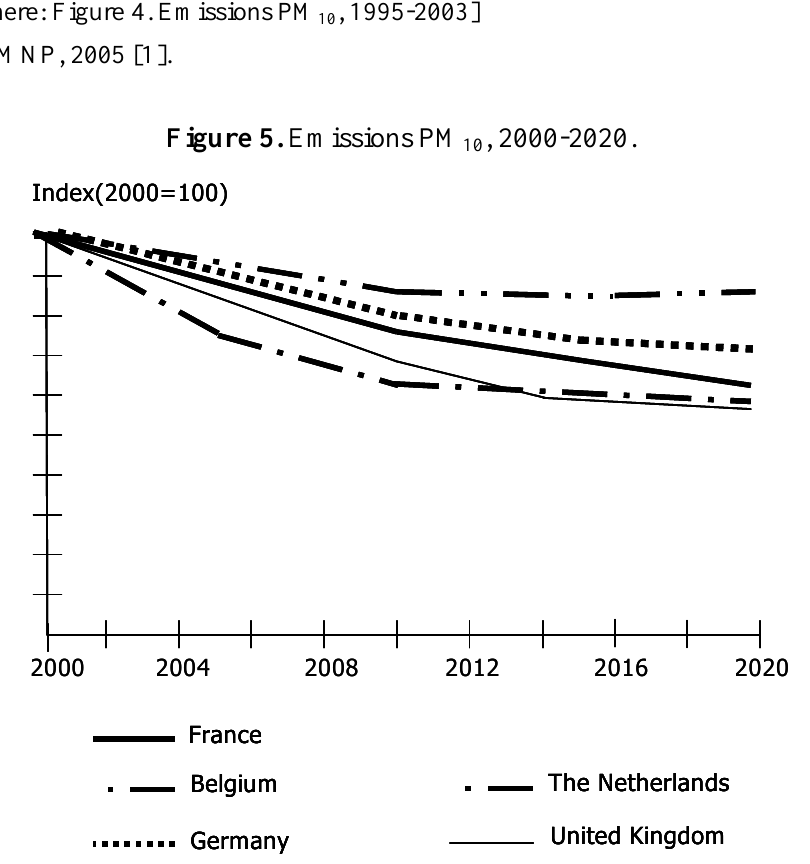
Figure 5. Emissions PM